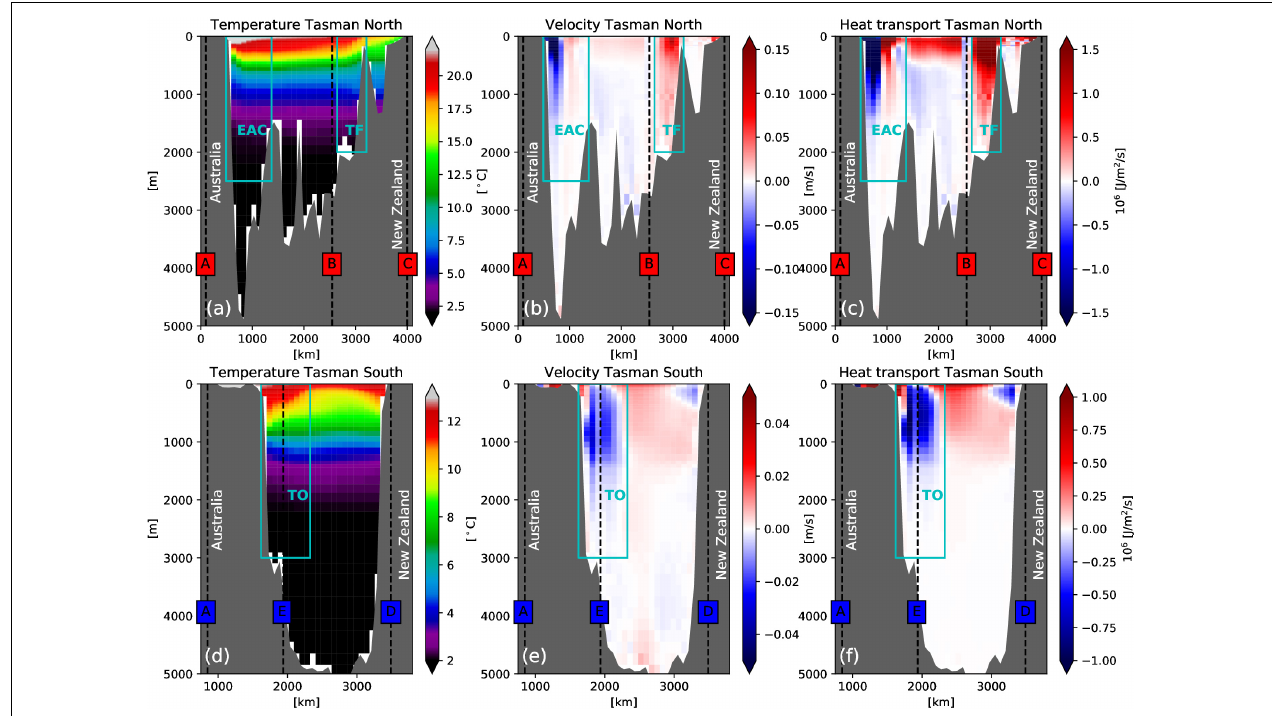
FIGURE 4 | Time averaged (1970–2017) quantities along Tasman North (ABC) and Tasman South section (CDEA). (a,d) Temperature in ◦ C, (b,e) cross section velocity in m/s and (c,f) heat transport in 10 6 J/m 2 /s. Specific currents have been labeled, with TF (Tasman Front), EAC (East Australian Current) and TO (Tasman Outflow). In addition the boundary points of the Tasman box have been labeled with (A)-(E). Gray shaded area is the model bathymetry. Transports follow the common sign convention where positive transports show northward or eastward transports. Segments A-B and D-E show meridional transports, while B-C and E toward Australia are zonal